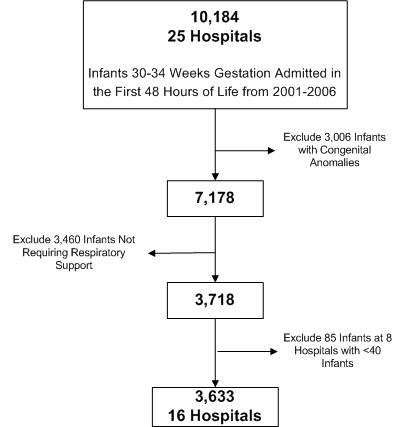
Inclusion and exclusion criteria applied to identify the study population. This figure displays how inclusion and exclusion criteria were applied to identify the study population. Prior to obtaining data from PHIS, 11 hospitals that do not submit gestational age information were excluded. From the initial study population of infants 30 to 34 weeks gestation admitted in the first 48 hours of life, exclusion criteria were applied sequentially.